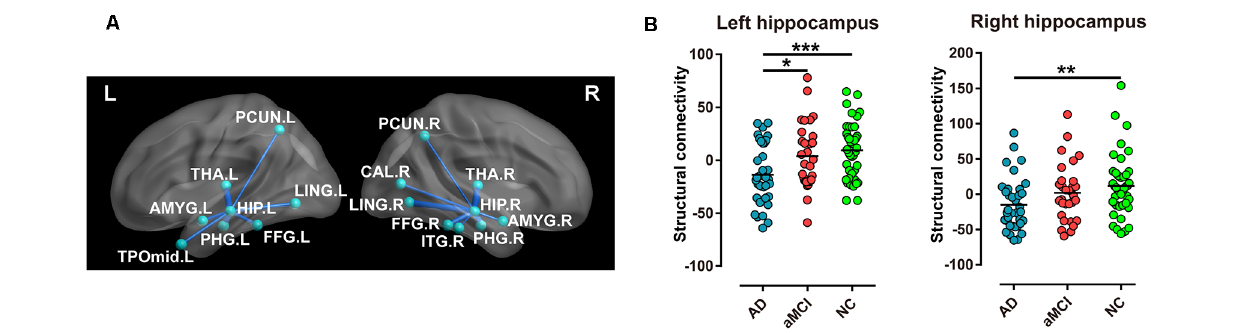
FIGURE 2 | Every two groups were compared for structural connectivity (sum of the number of connecting fibers) between the hippocampus and the brain regions in the AD, aMCI, and NC groups. (A) Blue lines imply structural connectivity between the hippocampus and the corresponding brain regions. The width of the lines represents the number of connecting fibers. (B) Structural connectivity (sum of the number of connecting fibers) of the bilateral hippocampi displayed a significant difference in special comparisons of the two groups (*** P < 0.001; ** P < 0.01; * P < 0.05). Abbreviations: PCUN, precuneus; THA, thalamus; LING, lingual gyrus;